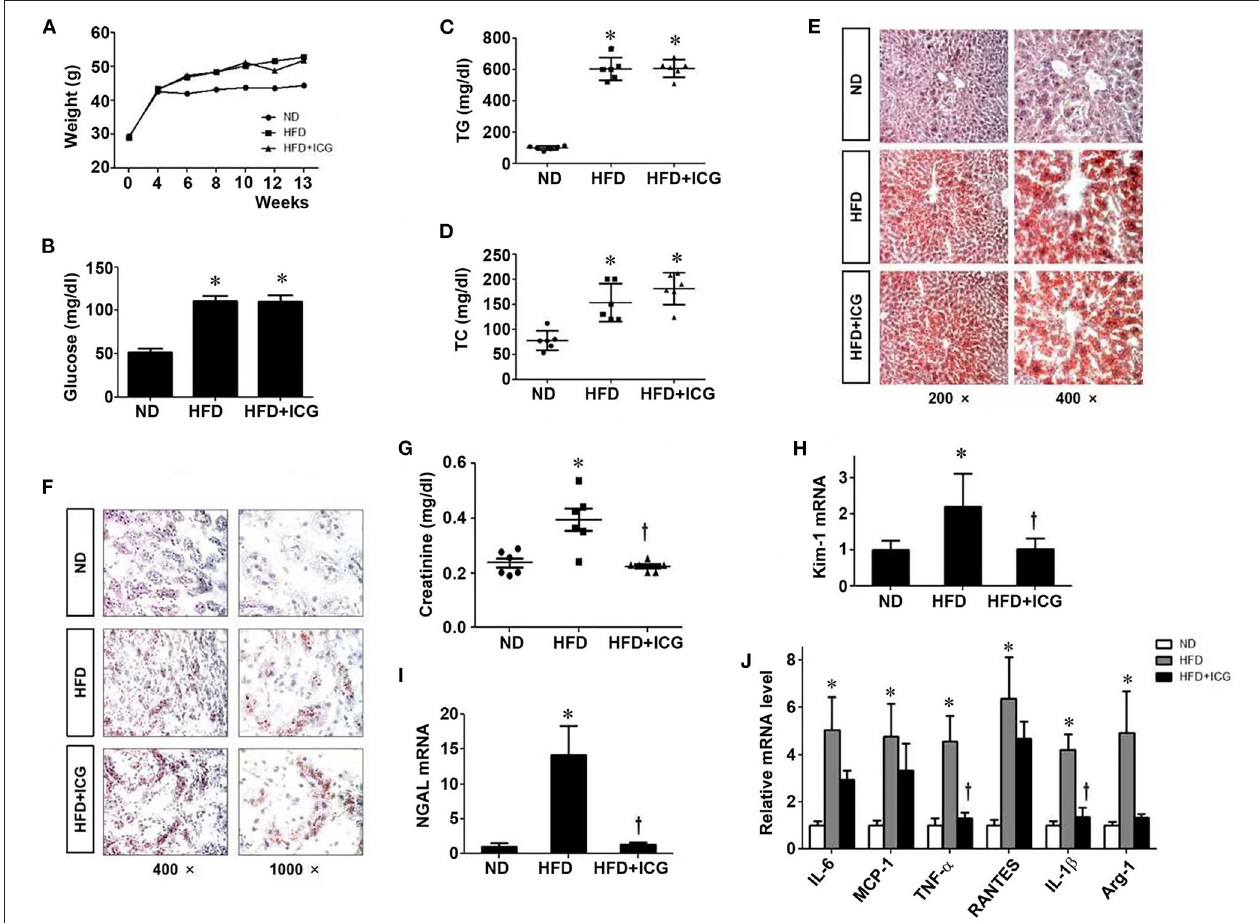
FIGURE 3 | ICG-001 ameliorates kidney injury in mice on high-fat diet. After 4 weeks with high-fat diet, mice were injected with Wnt signaling inhibitor ICG-001 or vehicle (DMSO). Body weight (A) , blood glucose (B) , plasma triglyceride (C) , plasma total cholesterol (D) were measured at 9 weeks after ICG-001 treatment. (E,F) Oil-red staining for local lipid deposition in liver (E) and kidney (F) . (G) Serum creatinine levels. (H,I) Kidney injury was assessed by the markers of renal tubular damage, Kim-1 (H) and NGAL (I) . (J) Renal expression of various cytokines was assessed by real-time PCR. ND, normal die; HFD, high-fat diet; TG, triglyceride; TC, total cholesterol. * P < 0.05, ND vs. HFD, † P < 0.05 HFD vs. HFD-ICG, n =